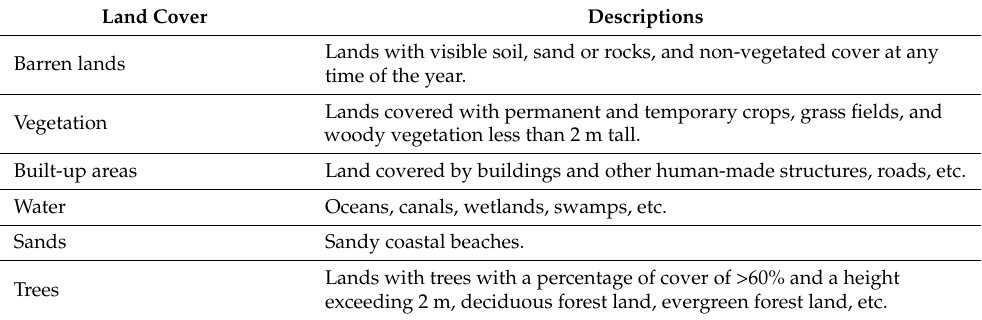
Table 1. Description of land use types. Land Cover